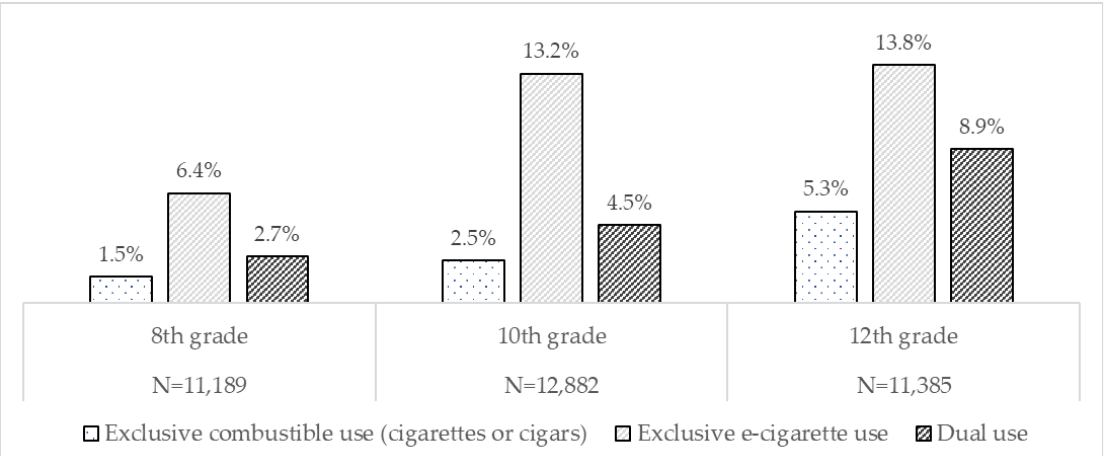
Figure 1. Prevalence of exclusive and dual use of combustibles (cigarette and cigars) and e-cigarettes among eighth, tenth, and twelfth graders: Monitoring the Future Surveys, 2017 to 2020.